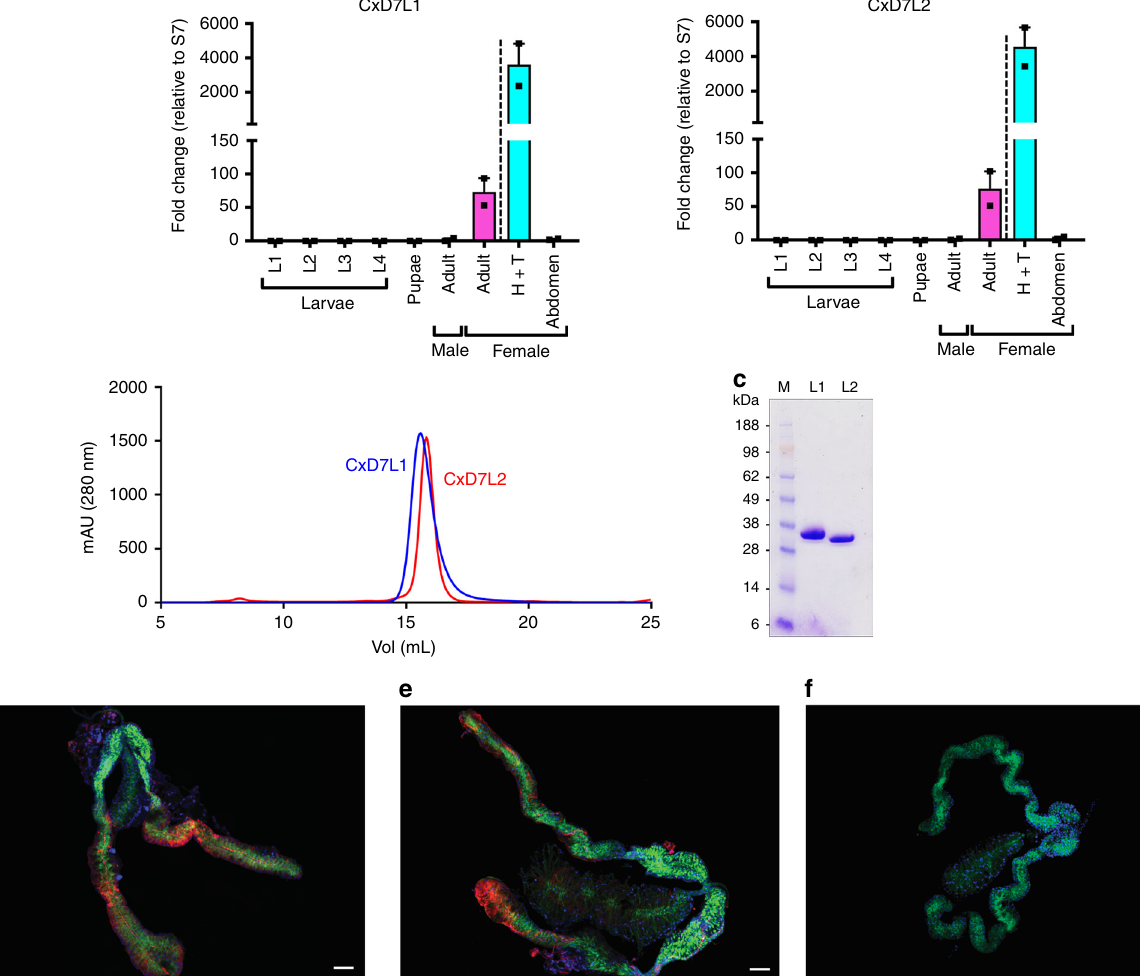
Fig. 1 Characterization of C. quinquefasciatus salivary long D7 proteins. a Gene expression analysis of CxD7L1 and CxD7L2 transcripts in different stages of C. quinquefasciatus mosquitoes. Relative abundance was expressed as the fold change using the 40S ribosomal protein S7 as the housekeeping gene. Larvae stage 1 (L1), larvae stage 2 (L2), larvae stage 3 (L3), larvae stage 4 (L4), pupae, male adult (reference sample), female adult, heads and thoraxes (H + T), and abdomens from female adult mosquitoes were analyzed separately. Two biological replicates and two technical duplicates were analyzed. Bars indicate the standard error of the means. b Puri fi cation of CxD7L1 (blue line) and CxD7L2 (red line) by size exclusion chromatography using Superdex 200 Increase 10/300 GL column. c Coomassie-stained NuPAGE Novex 4 – 12% Bis – Tris gel electrophoresis ( n = 1) of recombinant proteins CxD7L1 and CxD7L2 (1.5 µ g). SeeBlue Plus2 Pre-stained was used as the protein standard (M). d , e Immunolocalization of CxD7L1 and CxD7L2 proteins in the salivary glands of C. quinquefasciatus . Salivary glands were incubated with rabbit IgG anti-CxD7L1 ( d ), anti-CxD7L2 ( e ), and further stained with anti-rabbit IgG Alexa Fluor 594 antibody shown in red. Proteins of interest were localized in the medial and distal regions of the lateral lobes of C. quinquefasciatus salivary glands. As a control, salivary glands were incubated with anti-rabbit IgG AF594 alone ( f ). Nucleic acids were stained by DAPI (blue) and the actin structure of salivary glands was stained using Phalloidin Alexa 488 (green). Four independent experiments were performed with 1 – 2 glands imaged per experimental group. Scale bar = 50 µ m. Source data are provided as a Source Data fi